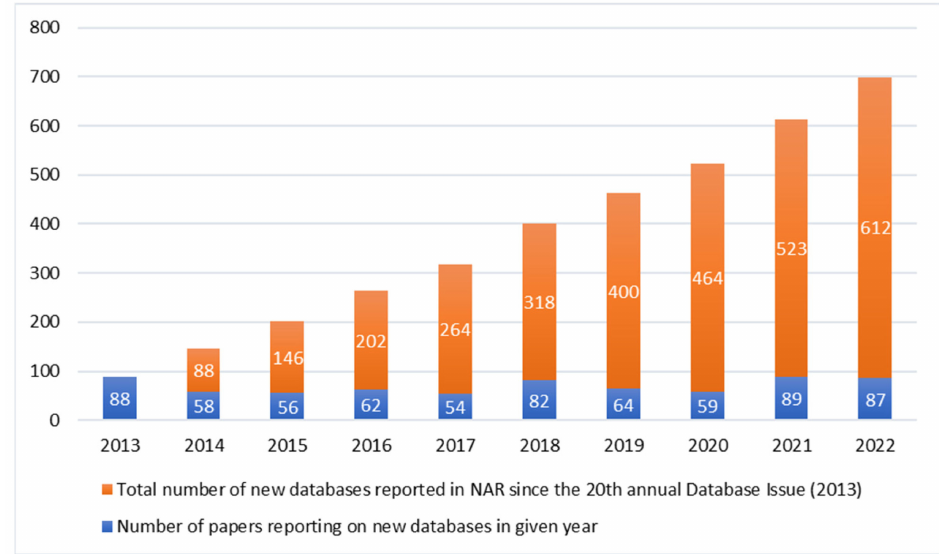
Figure 1. New databases reported in Nucleic Acids Research database issue in the last 10